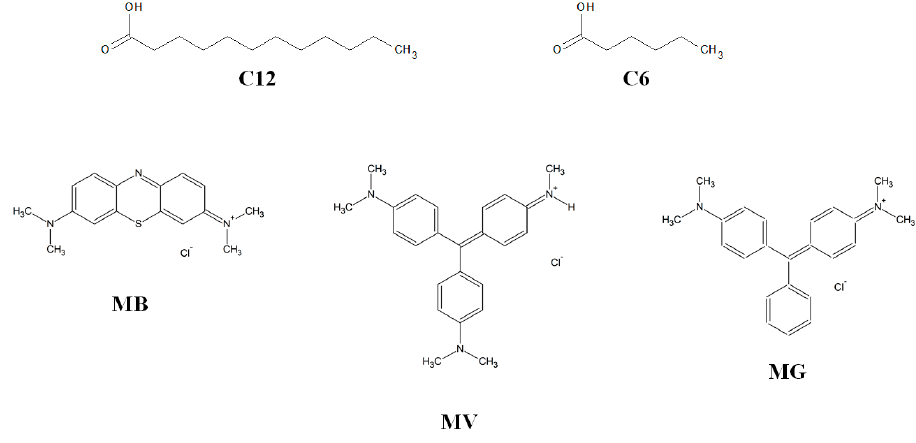
Figure 1. Chemical structures of the fatty acids and dyes used in this study.